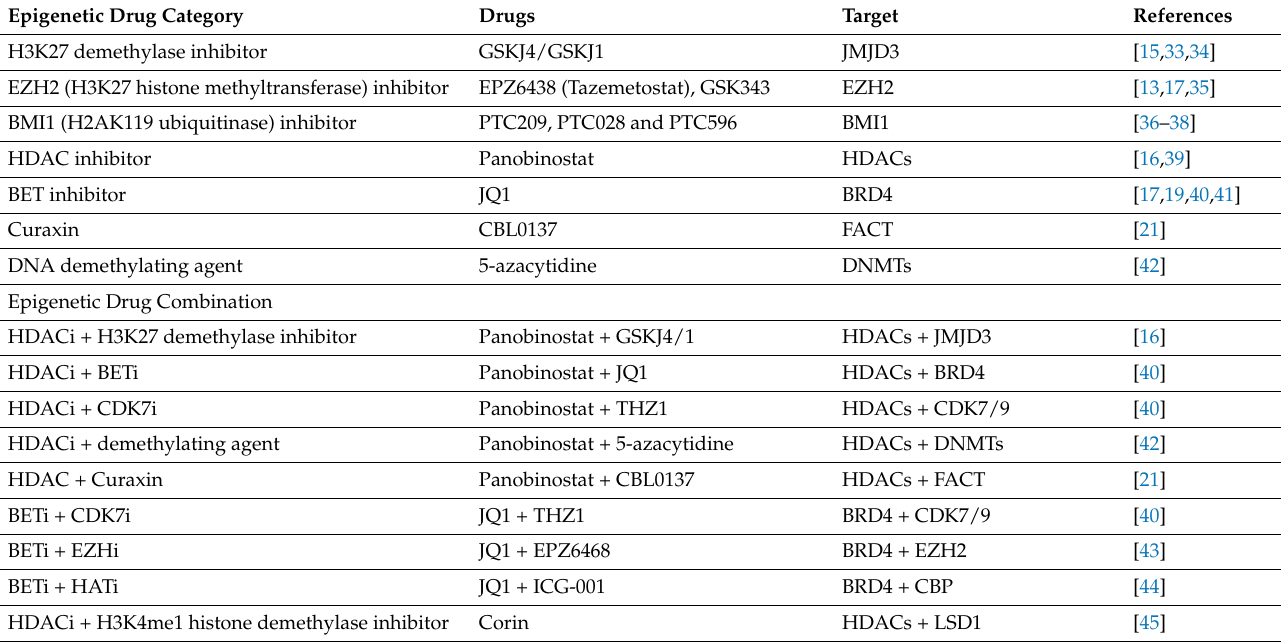
Table 1. Summary of inhibition studies targeting epigenetic mechanisms in